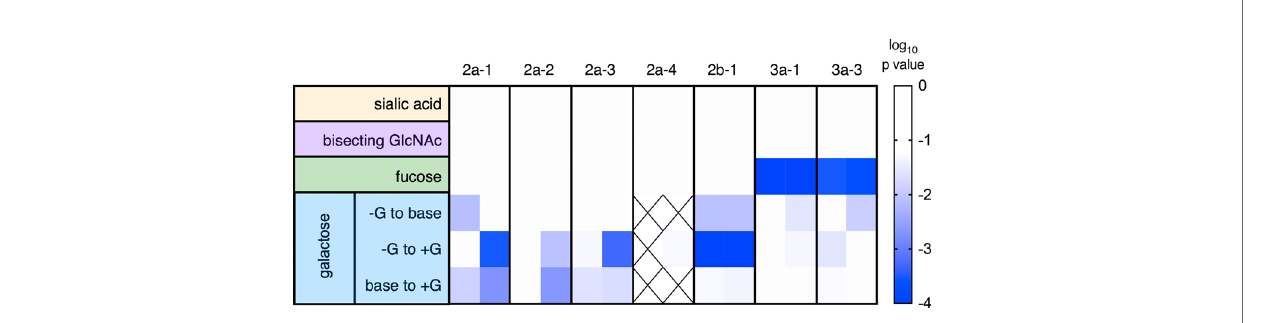
FIGURE 3 | Summary of receptor af fi nity differences. Statistical signi fi cance of differences in af fi nity associated with variable glycosylation. Glycan modi fi cations are tabulated by row and receptors by column, for each of the two independent experimental runs. Con fi dence in differences is indicated in color. Crosshatches indicate missing data. The effect of varying (+ versus -) sialic acid, bisecting GlcNAc, and fucose were evaluated by unpaired t test, and for galactose [+G, unmodi fi ed (base), and -G] with an ordinary one-way ANOVA corrected for multiple comparisons.